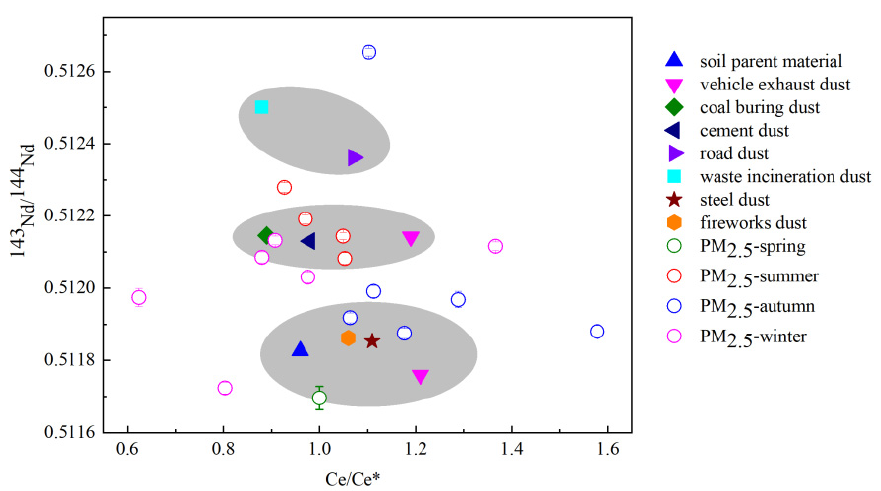
Figure 5. Relationship between Nd isotope compositions and Ce/Ce* of PM 2.5 and potential sources in Xiamen.